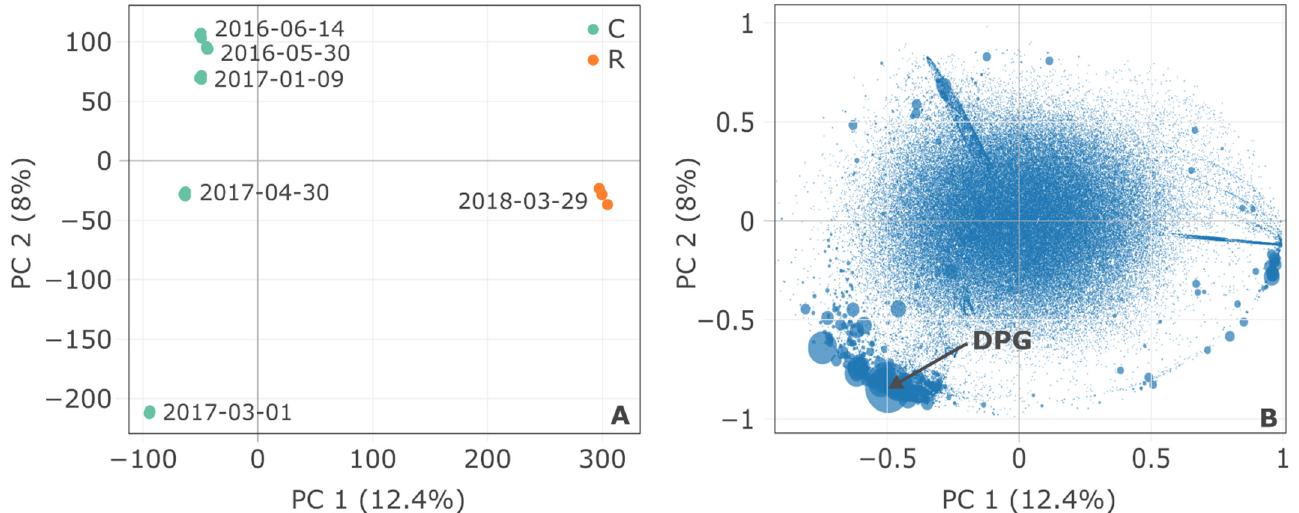
Figure 4. Principal component analysis of HRMS features. ( A ) Scores plot showing samples with corresponding sampling dates for the C and R sites; ( B ) Loadings plot showing all features detected in the samples, with the size of bubbles proportional to the highest intensity of a given feature among all samples.